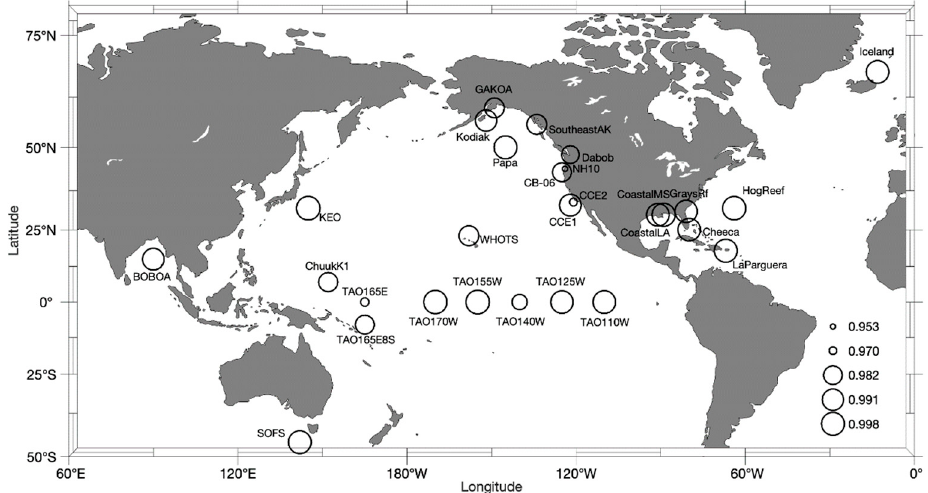
Figure 8. Spatial distribution of correlation coefficients between calculated diurnal and nocturnal CO 2 fluxes.